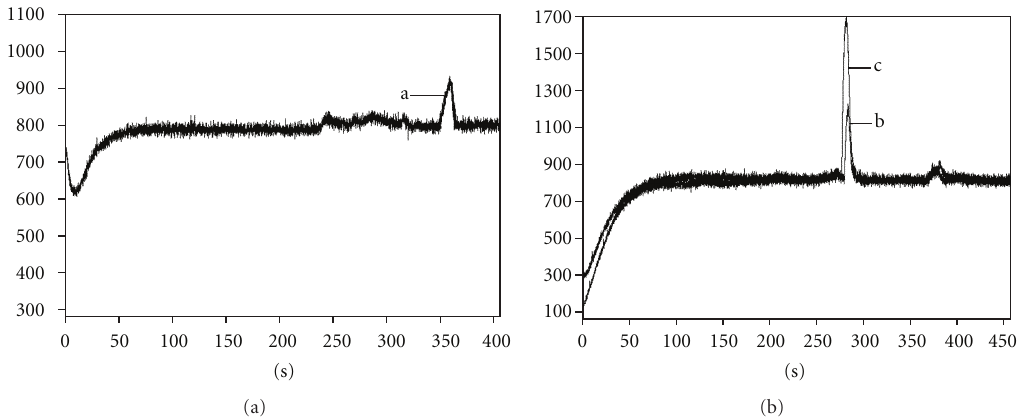
Figure 6: Electropherograms of (a) the diluted urinary sample of a healthy male; (b) the diluted urinary sample of a male patient; (c) the diluted urinary sample of the male patient spiked with 5.0 μ g · mL − 1 atropine sulfate standard solution; other conditions are the same as in Figure 3.